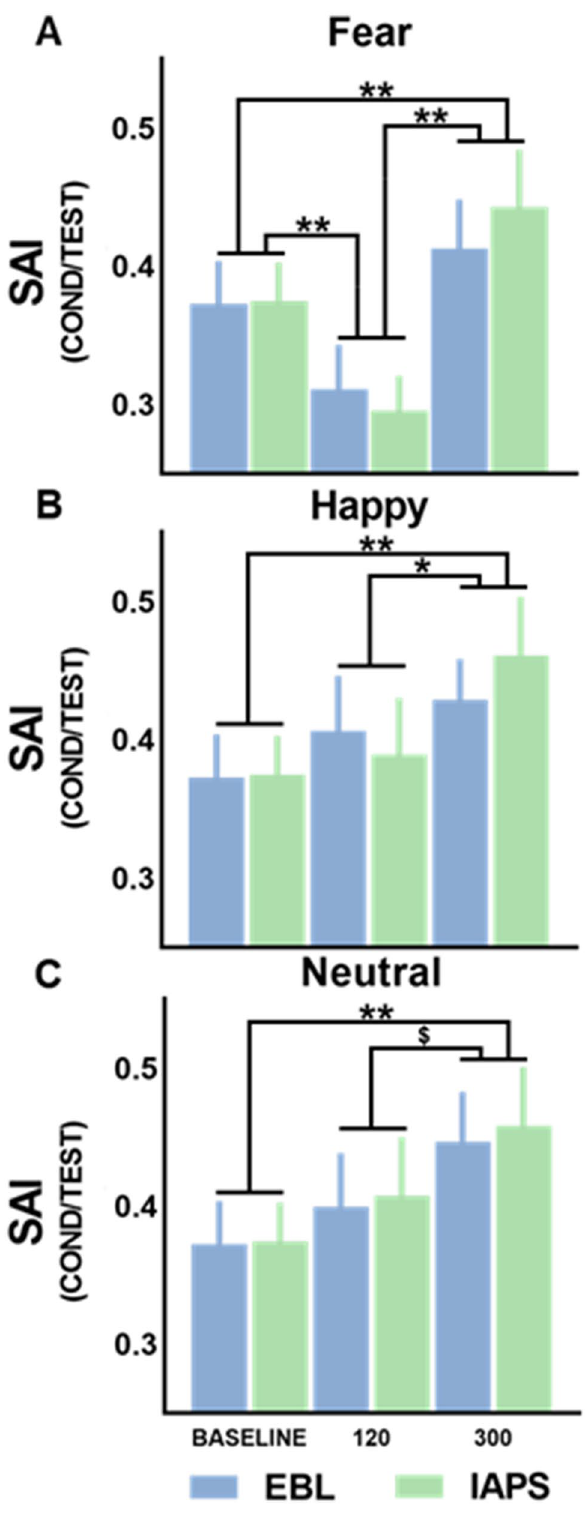
Figure 3. SAI data. All SAI data are graphically reported. In ( A ), the increase of SAI at 120 ms after stimulus onset for fearful stimuli is observable in both conditions (EBL and IAPS) in the comparison with SAI recorded at baseline (no visual stimuli). At 300 ms after stimulus onset, SAI was decreased compared to baseline for all emotional ( A , B ) and neutral stimuli ( C ) in both conditions (EBL and IAPS). SAI data (MEP conditioned/ MEP test) are reported on the y-axis, while the three timepoints at which SAI was tested (Baseline, 120 ms and 300 ms) are reported on the x-axis. *p < 0.05, **p < 0.01, $ p > 0.05